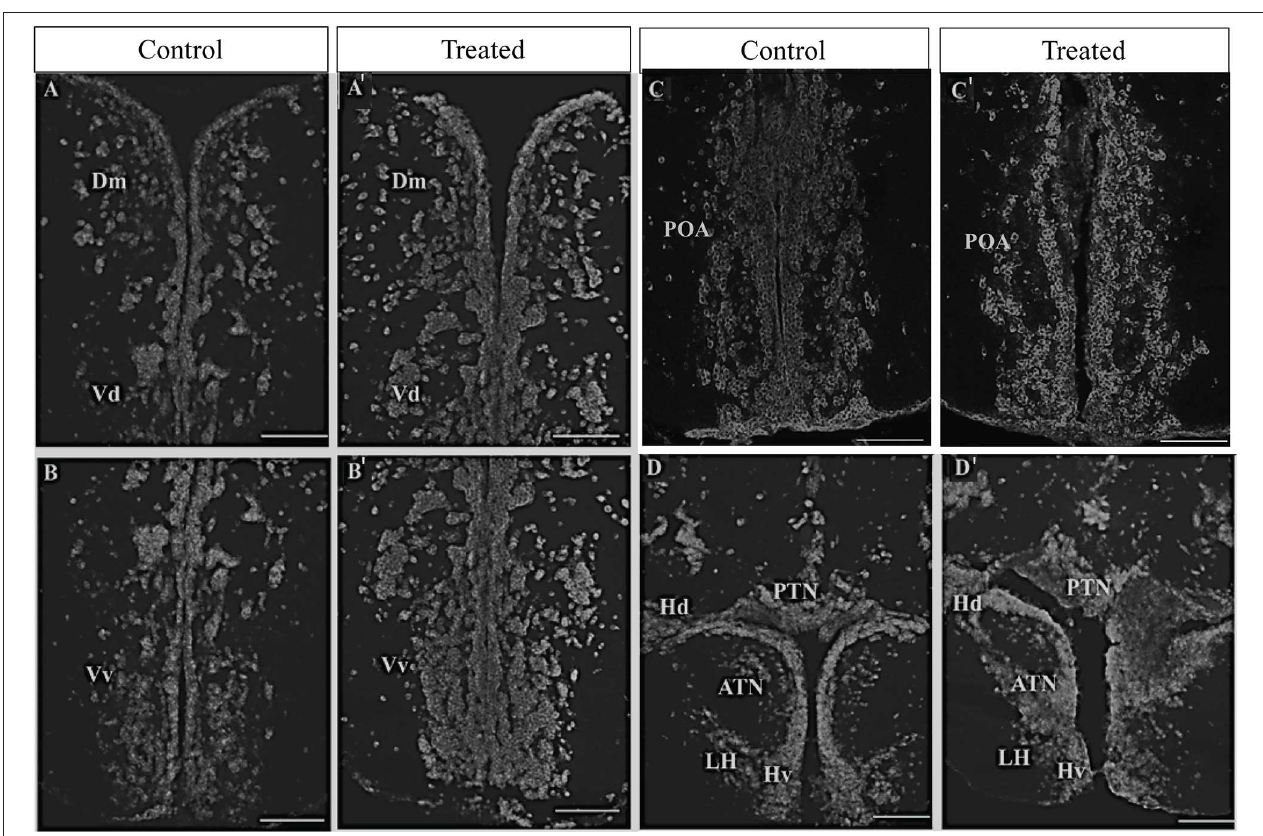
FIGURE 4 | Effect of morphine on oprm1 mRNA expression in the brain of zebrafish. Fish were individually immersed in morphine 2 mg/L (treated) or water (control) for 20min and then the brain samples were collected. (A–D ′ ) Photomicrographs showing expression of oprm1 genes. ( A ; control and A ′ ; morphine treated) Medial zone of the dorsal telencephalic area and dorsal nucleus of the ventral telencephalic area, (B,B ′ ) ventral nucleus of the ventral telencephalic area, (C,C ′ ) posterior part of preoptic area, and (D,D ′ ) ventral periventricular hypothalamus. N = 6 each group. Scale bars: (A–D) and (A ′ -D ′ ) (100 µ